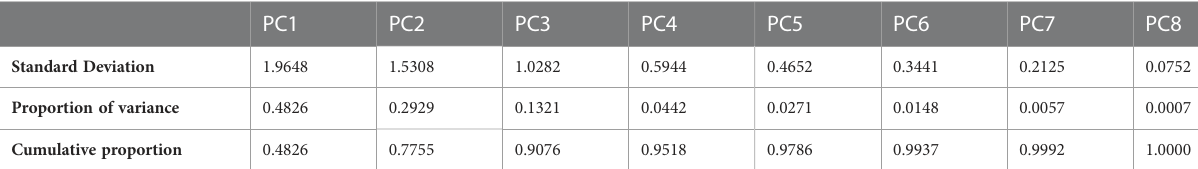
TABLE 3 Variance explained by the PC1-PC8 with standard deviation and cumulative proportion.